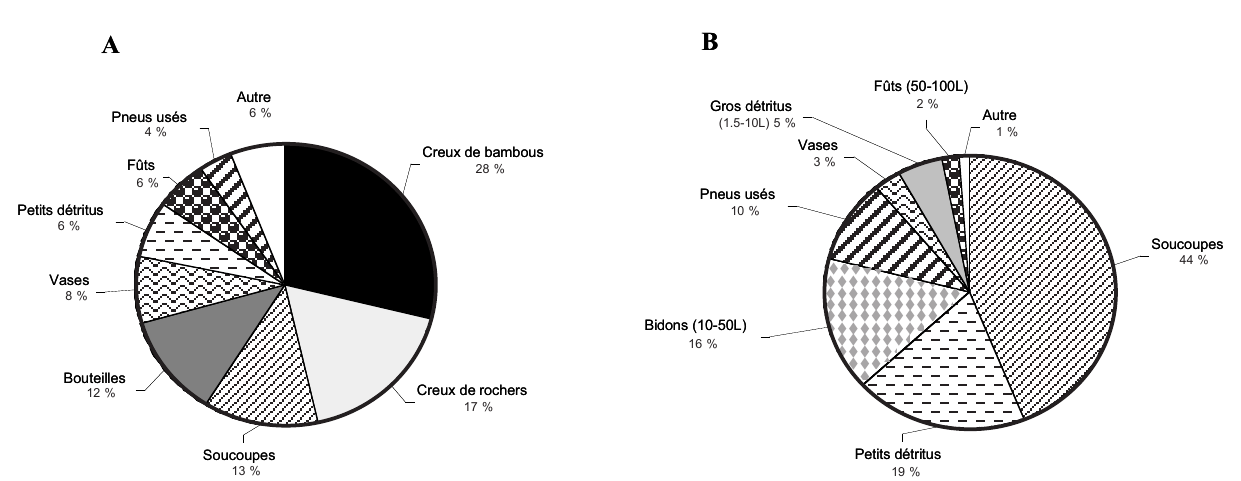
Fig. 2. – Typologie des gîtes larvaires d’ Aedes albopictus à l’île de la Réunion en zone péri-urbaine/rurale (A) et en zone urbaine